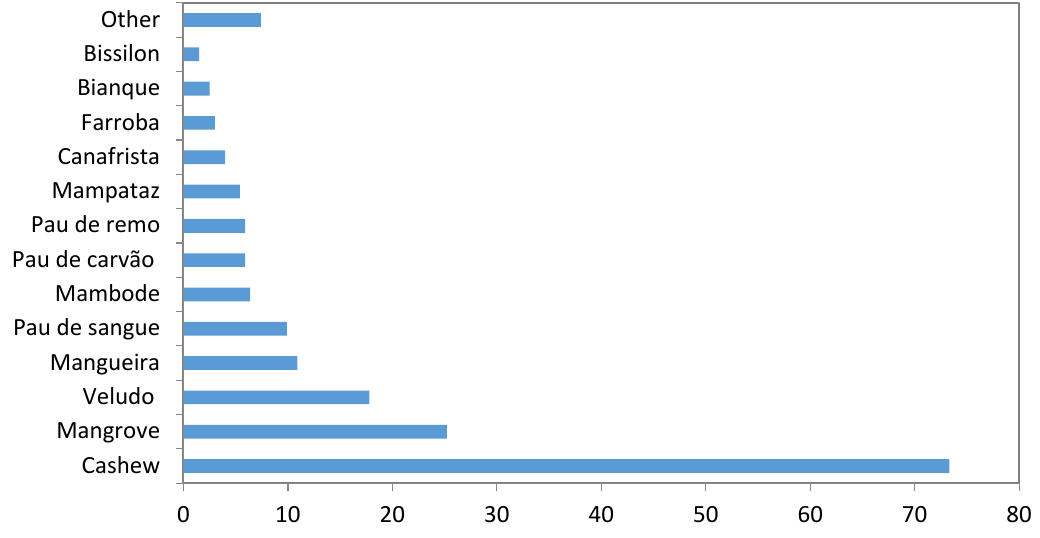
Figure 3. Tree species used for fuel wood (vernacular names as collected during